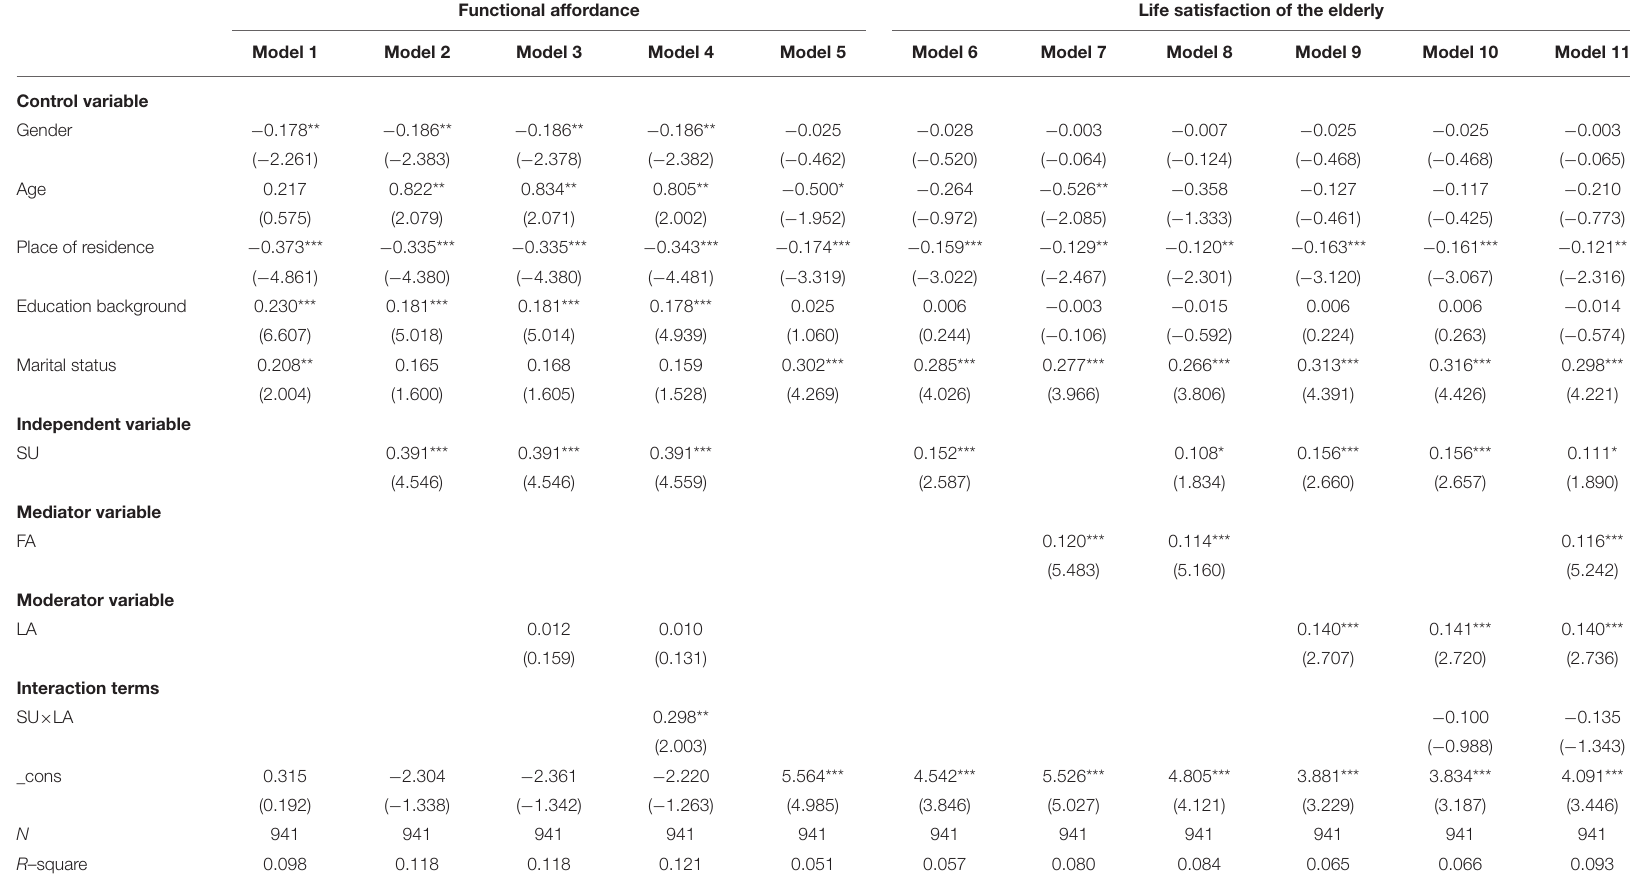
TABLE 5 | The hierarchical regression results including mediating effect of functional